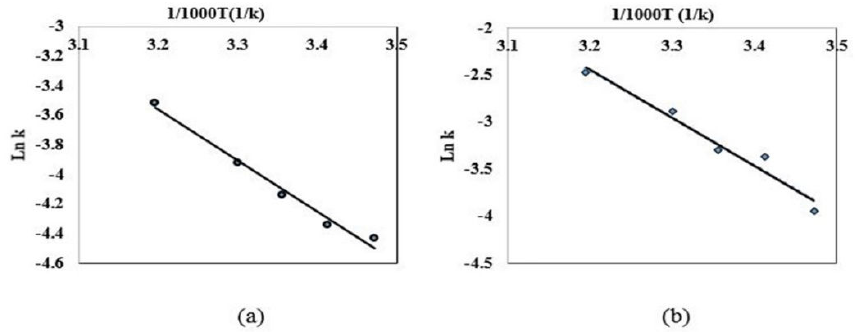
Fig. 7. Arrhenius plots of the natural logarithm of rate constant (k) vs. 1/T (a) adsorption step, and (b) reductive degradation step Table 5. Comparison of efficiency the proposed method with other reported methods in reductive degradation of perchlorate from aqueous solutions